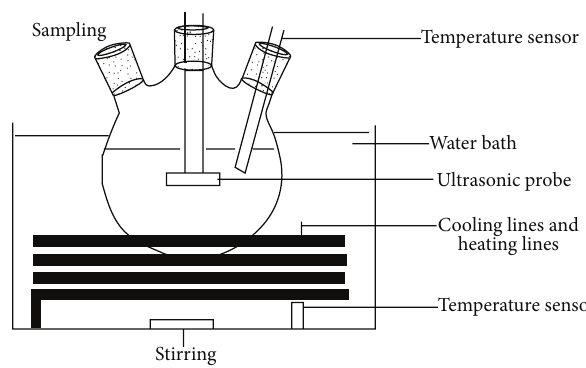
Figure 1: Chemical formula of fuchsin basic. Figure 2: Schematic diagram of the experimental